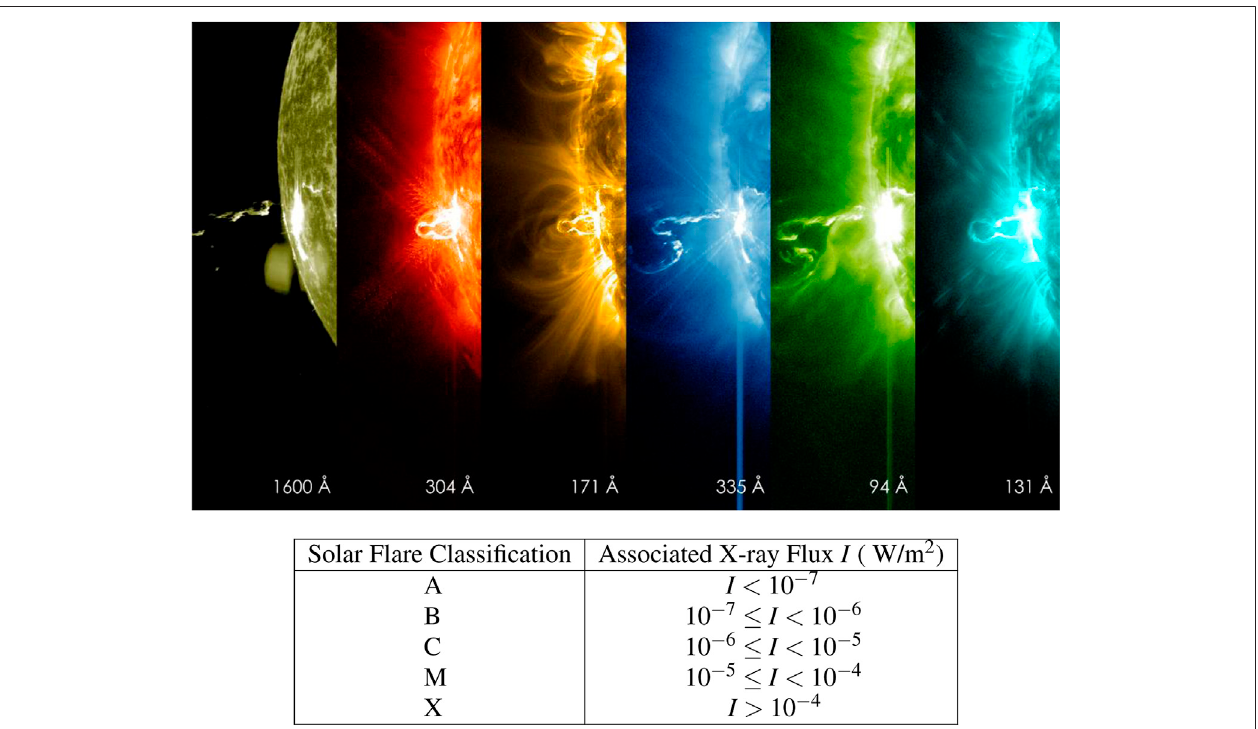
FIGURE 5 | Top panel: This image illustrates a solar fl are seen in different wavelengths of ultraviolet light, from 1,600 Å on the left to 94 Å and 131 Å on the right. Note that since fl ares are EM radiation events, they are visible in multiple wavelengths as depicted in the fi gure above. Image Credit: NASA/SDO. Bottom panel: Description of solar fl are classes where the de fi nition of the fl are classes is based upon their peak fl ux in X-rays of 1 – 8 Å (Discola Junior,